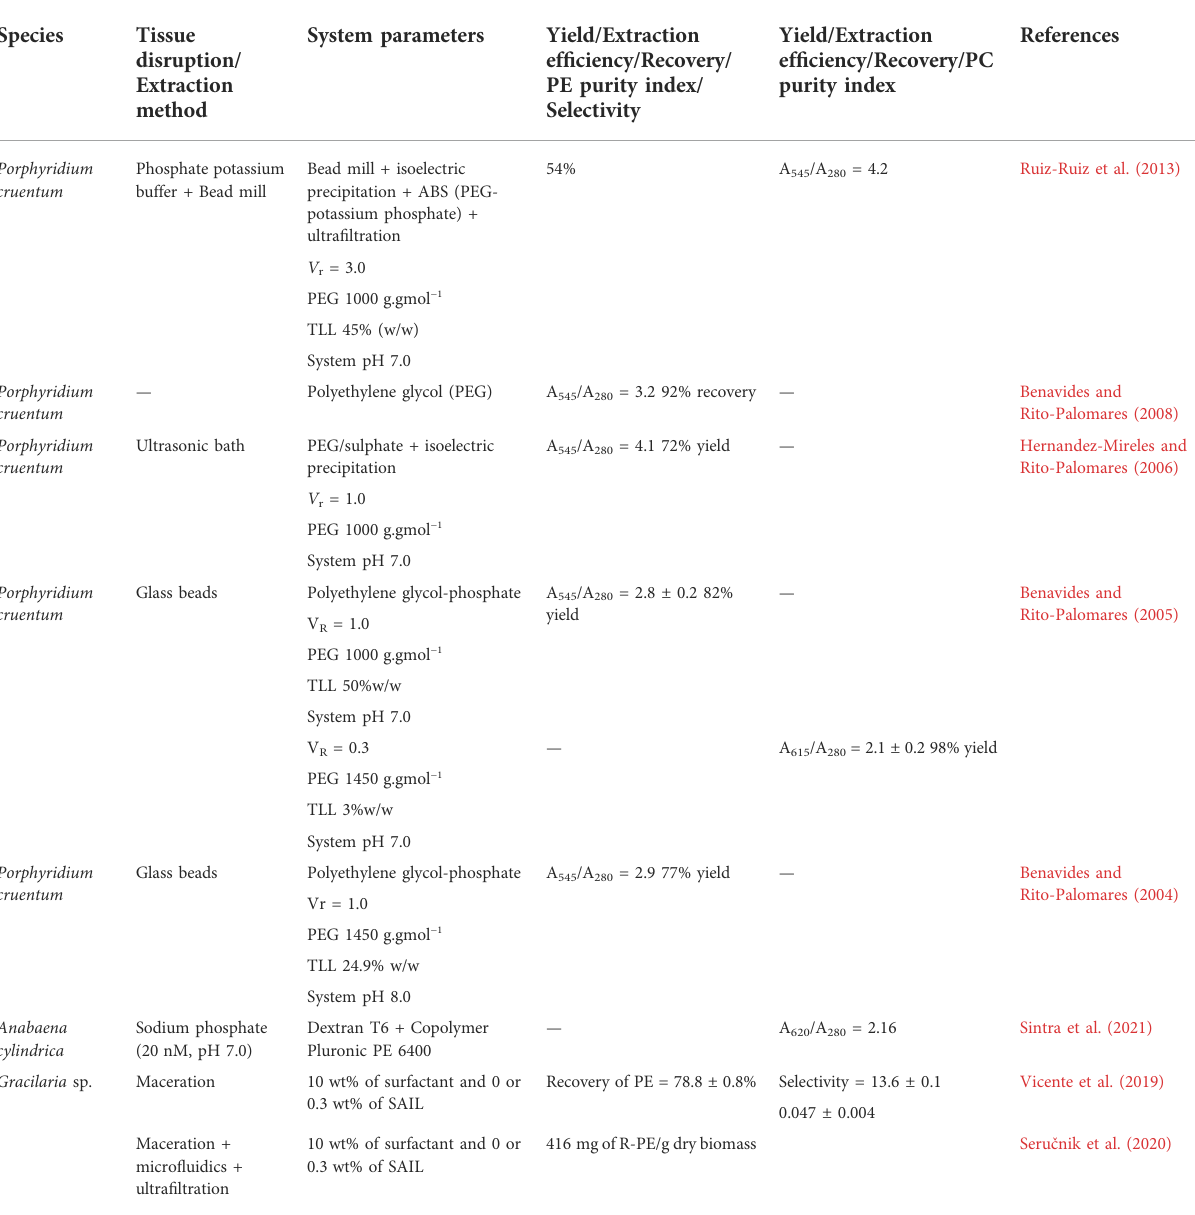
TABLE 5 ABS applied to the puri fi cation of phycobiliproteins.